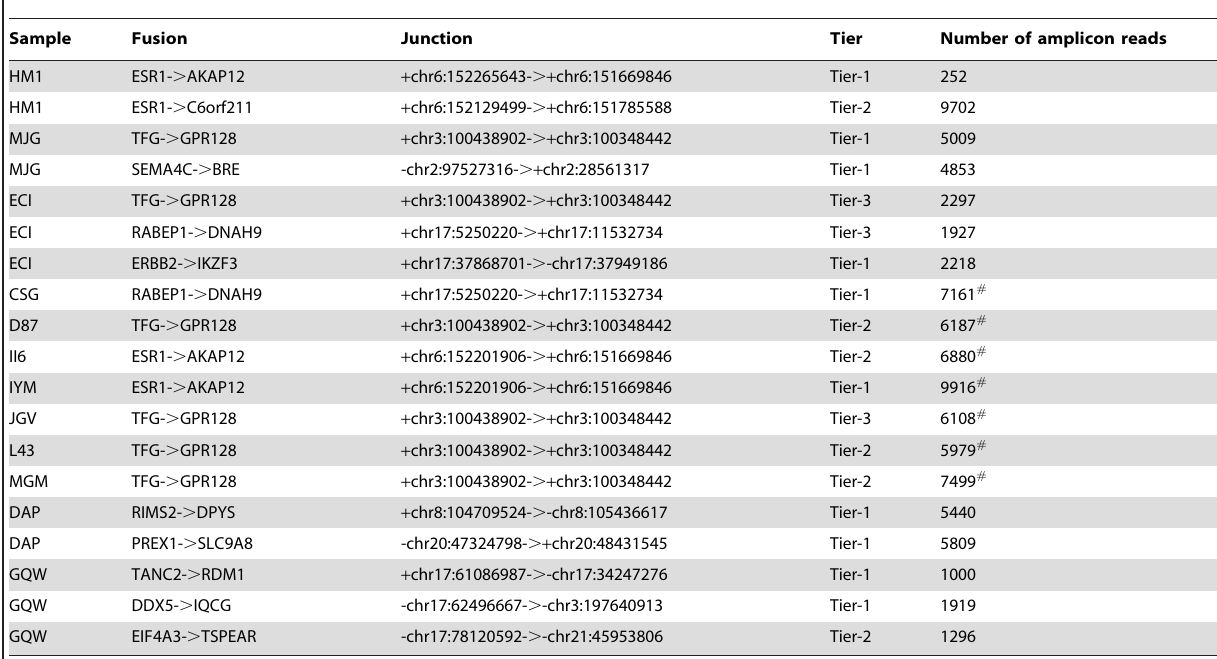
Table 1. Fusion junctions are confirmed by PGM sequencing of PCR amplicons.